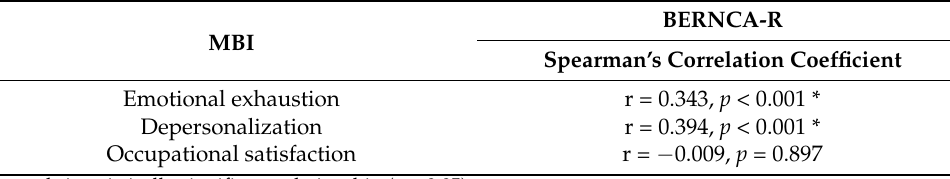
Table 6. Burnout and care rationing.